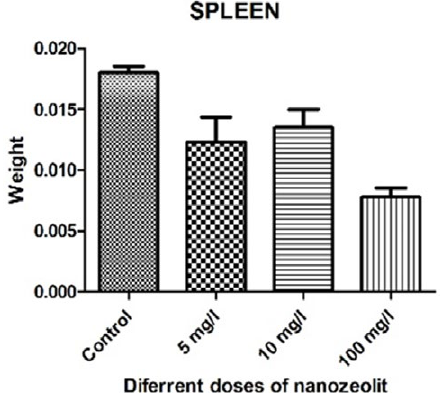
Fig. 3. showed that nanozeolite decreased significantly Fig. 5. decreased the liver weight at the dose of 5mg/L the spleen weight Fig.2. showed that nanozeolite decreased significantly the spleen weight Fig.4. decreased the liver weight at the dose of 5mg/L